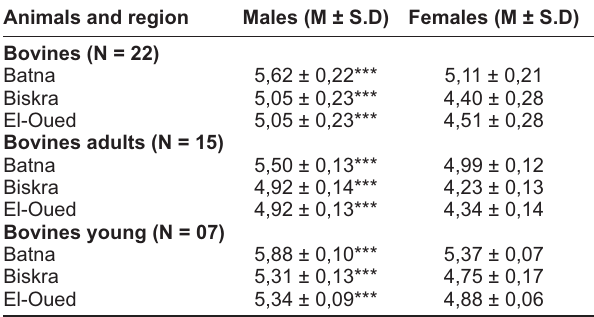
Table-2. Influence of sex on the size of Bovine erythrocytes (expressed in µm ) Animals and region